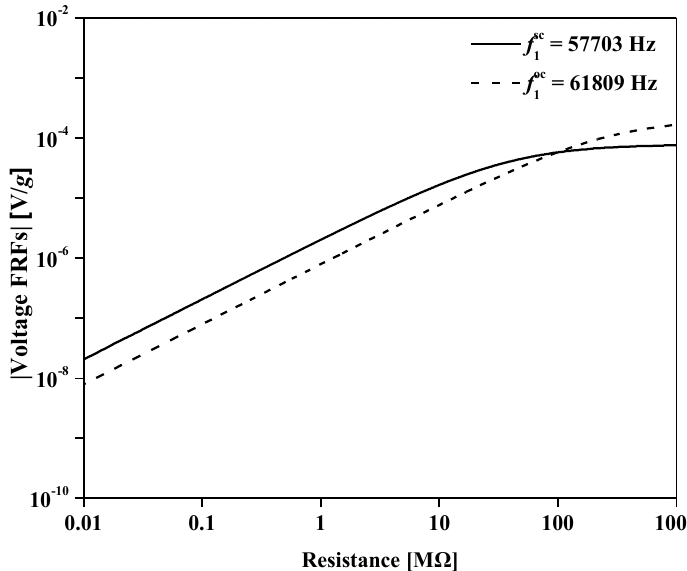
Figure 3. Voltage FRFs of the flexoelectric beam with 0.3 μm thickness over the frequency range of (a) the first three modes; (b) around the first mode.